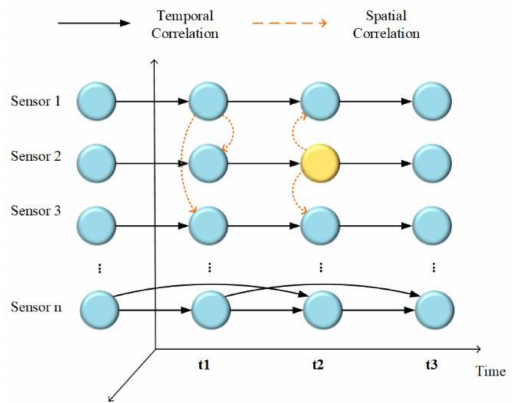
Figure 10. The temporal and spatial correlation in sensor data of axle bearing